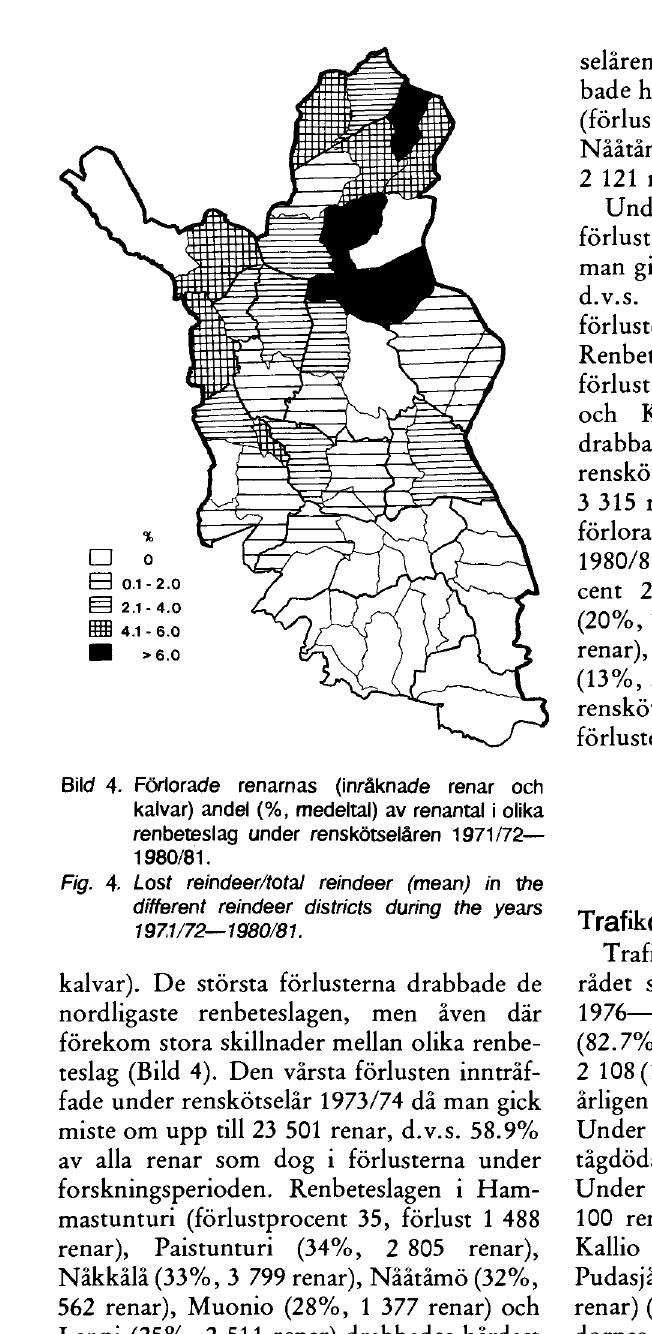
Fig. 4. Lost reindeer/total reindeer (mean) in the different reindeer districts during the